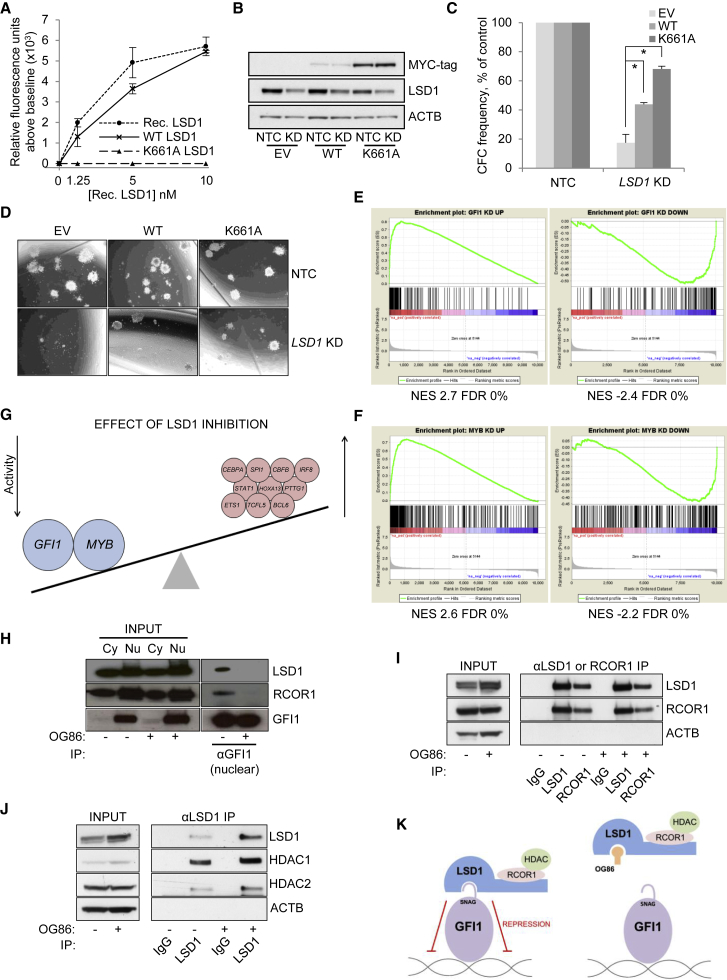
Catalytic Activity of LSD1 and Mimicry of LSD1 Inhibition by GFI1 Knockdown(A) Catalytic activity of recombinant LSD1, immunoprecipitated MYC-tagged wild-type (WT), or mutant (K661A) LSD1. Rec., recombinant.In (B)–(D), THP1 AML cells were infected with retroviruses expressing either WT or K661A mutant LSD1, or an empty vector (EV), with GFP as the selectable marker. FACS-purified GFP+ cells were then infected with lentiviruses expressing a shRNA-targeting LSD1 for knockdown (KD) or a non-targeting control (NTC), with puromycin drug resistance as the selectable marker.(B) Western blot shows expression of the indicated proteins in the indicated conditions after 48 hr of drug selection.(C) Bar graph shows mean ± SEM for colony-forming cell (CFC) frequencies of drug-resistant cells relative to controls, enumerated after 10 days in semisolid culture (n = 3). ∗p < 0.05 for the indicated comparison using one-way ANOVA and Fisher’s least significant difference post hoc test.(D) Representative images of colonies from (C).(E and F) GSEA plots show enrichment of gene sets regulated by (E) GFI1 KD or (F) MYB KD (Suzuki et al., 2009) among genes ranked according to fold change in expression following treatment of THP1 AML cells with 250 nM OG86 for 24 hr.(G) Image summarizes GSEA results. Blue circles indicate transcription factors where KD mimics transcriptional changes observed upon LSD1 inhibition. Pink circles indicate genes where KD induces downregulation of gene sets that are upregulated following LSD1 inhibition. Large circles indicate genes highlighted in (E) and (F).(H–J) THP1 AML cells were treated with 250 nM OG86 for 48 hr. Cell lysates were immunoprecipitated using (H) anti-GFI1, (I) anti-LSD1 or anti-RCOR1, and (J) anti-LSD1 in the indicated conditions, and western blots representative of at least three experiments are shown. IP, immunoprecipitation; Cy, cytoplasmic; Nu, nuclear.(K) Cartoon summarizes results of immunoprecipitation studies.See also Figure S2 and Tables S4 and S5.